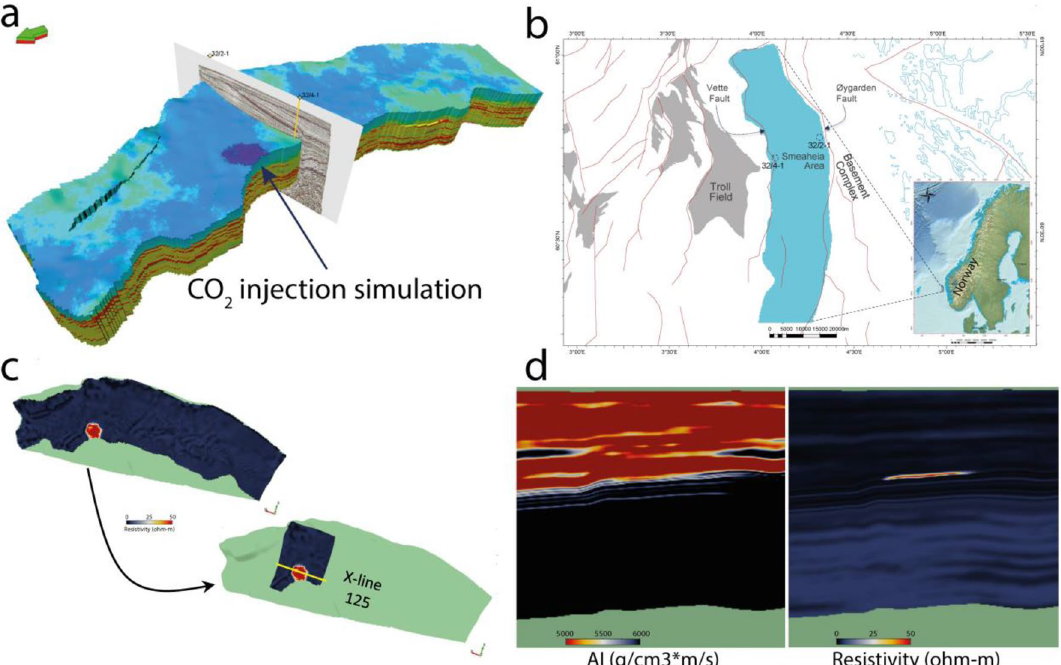
Figure 3. ( a ) Initial simulation modeling grid used for property extraction, ( b ) location of the modeled grid area (light blue) in the Norwegian North Sea, maps modified after NPD 15 , ( c ) example of resistivity grid carved out to a seismic formatted cube covering only the injection and storage area, ( d ) AI and resistivity profiles along crossline 125 shown in ( c ), the example here is of the year 2050, the effect of injected CO 2 on AI is not very obvious, however on resistivity profile one can see a significant anomaly.